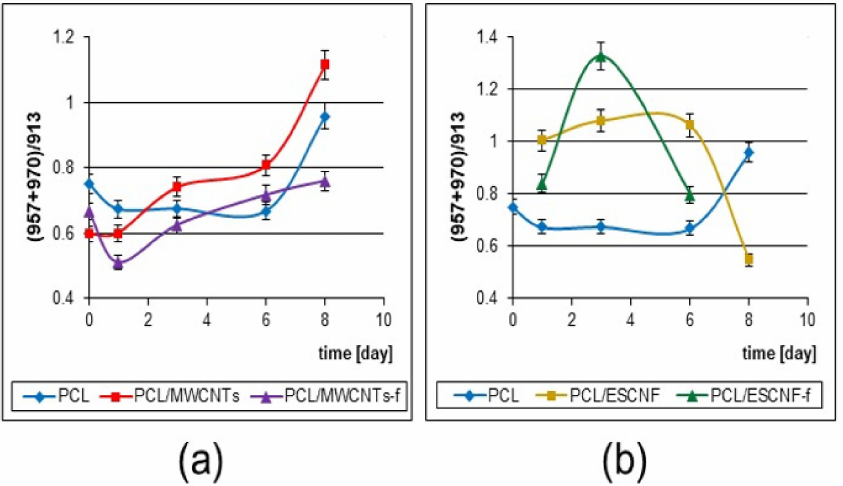
Figure 8. The intensity ratio (integral) of marker bands (957 + 970)/913 cm − 1 characterizing the growth and development of collagen for U-2 OS cells cultured on: ( a ) PCL, PCL/MWCNTs and PCL/MWCNTs-f (Statistical analysis with PCA with Calibration 98.61861%; Validation 95.60048%); ( b ) PCL, PCL/ESCNFs and PCL/ESCNFs-f (Statistical analysis with PCA with Calibration 99.90554%; Validation 99.07312%), variance is defined by y-axis error bars, OMNIC